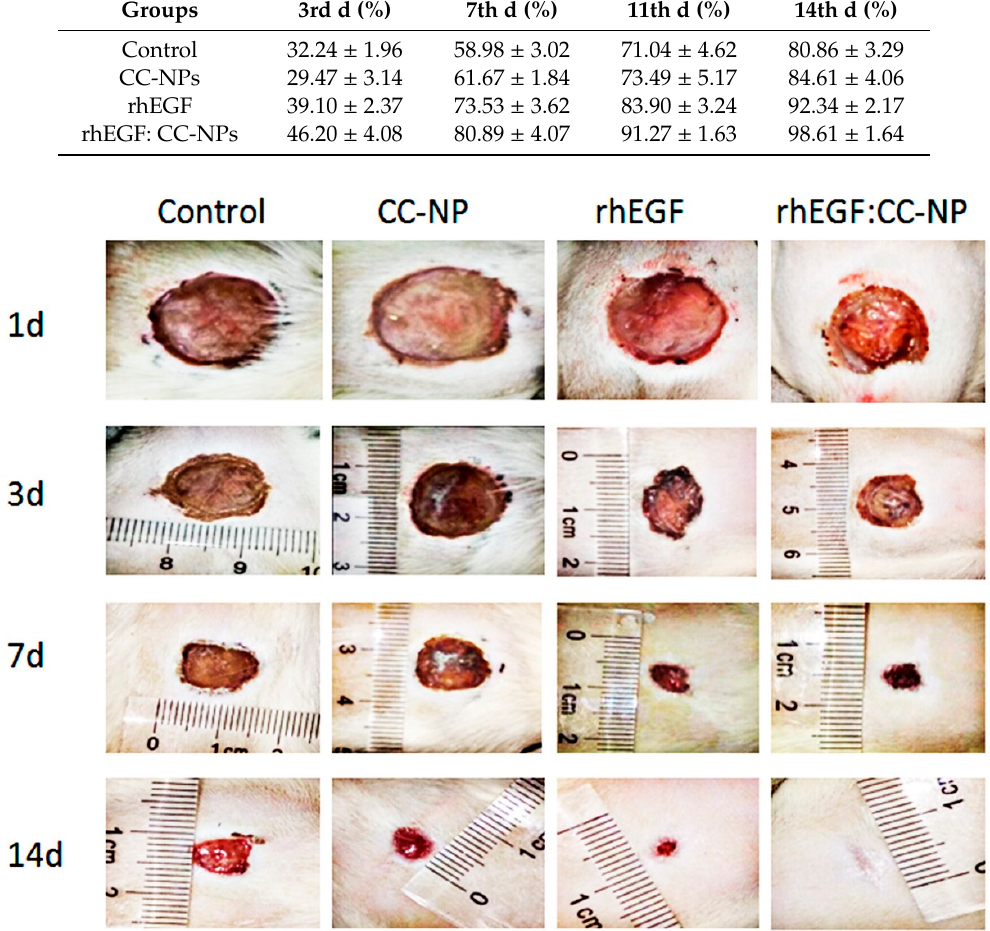
Figure 8. Wound images obtained from each treatment group.